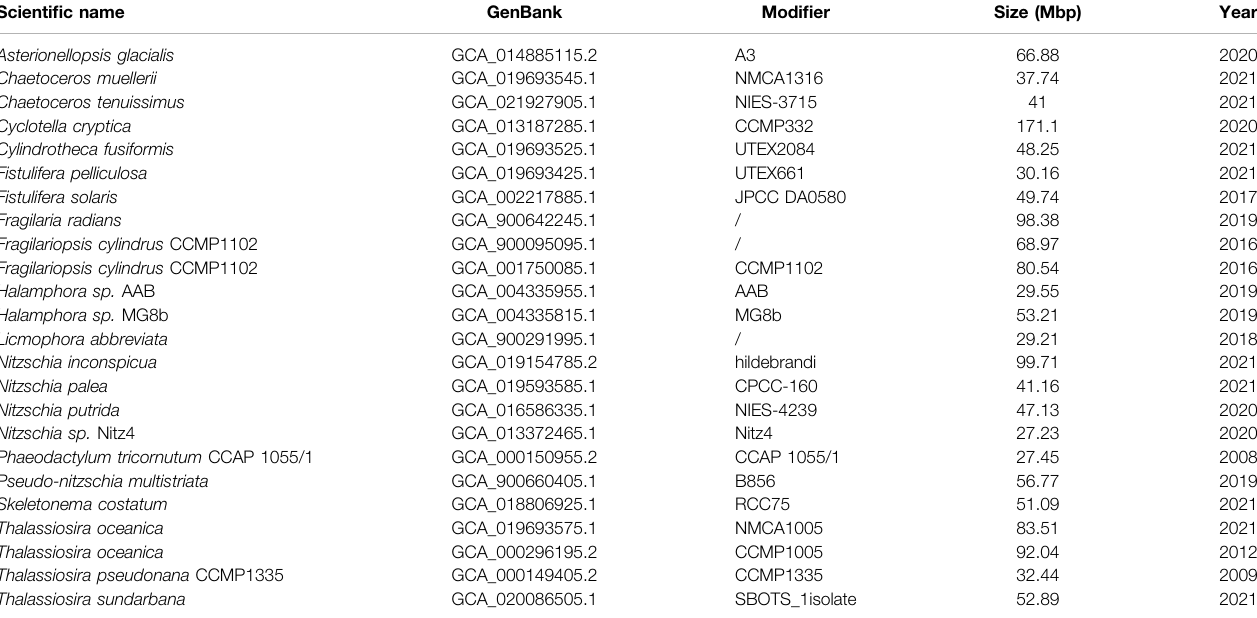
TABLE 2 | Summary of sequenced diatom